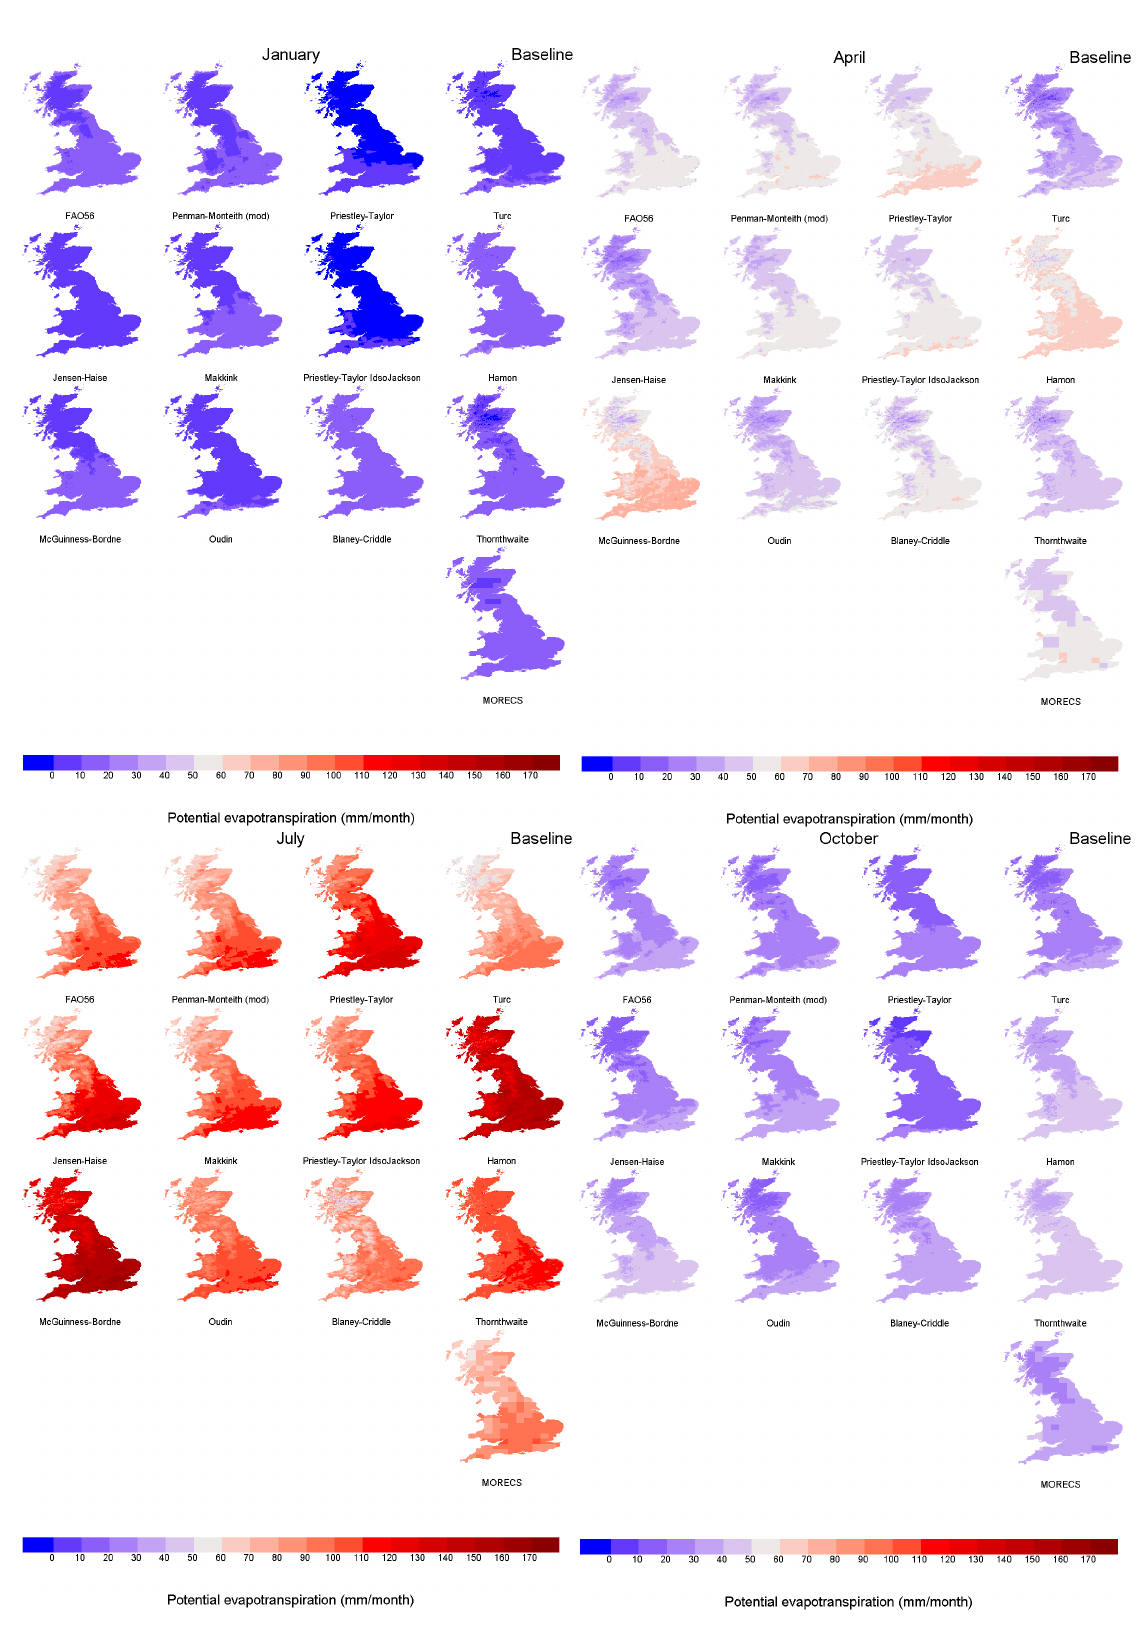
Fig. 2. Maps of average MORECS PET and PET derived from HadRM3-Q0 for the 1961–1990 time slice for four typical months.